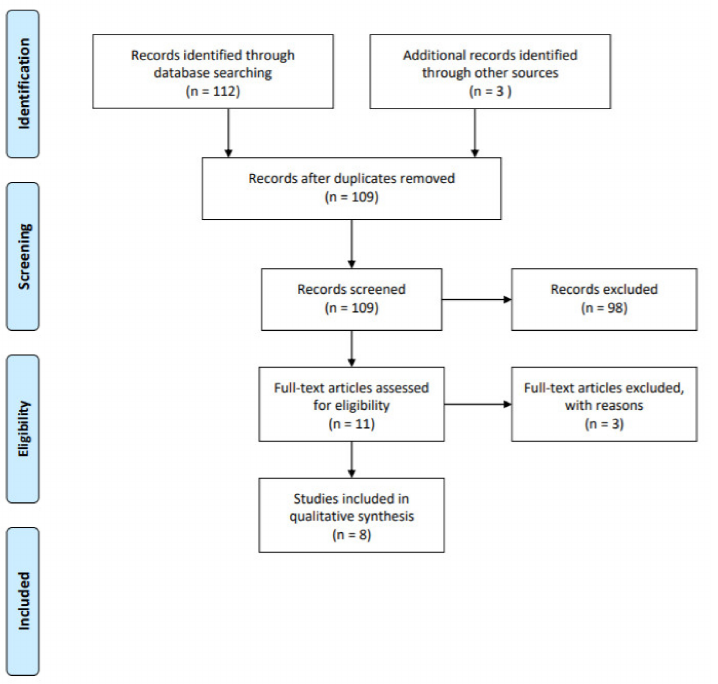
Figure 1. PRISMA flowchart for systematic review and